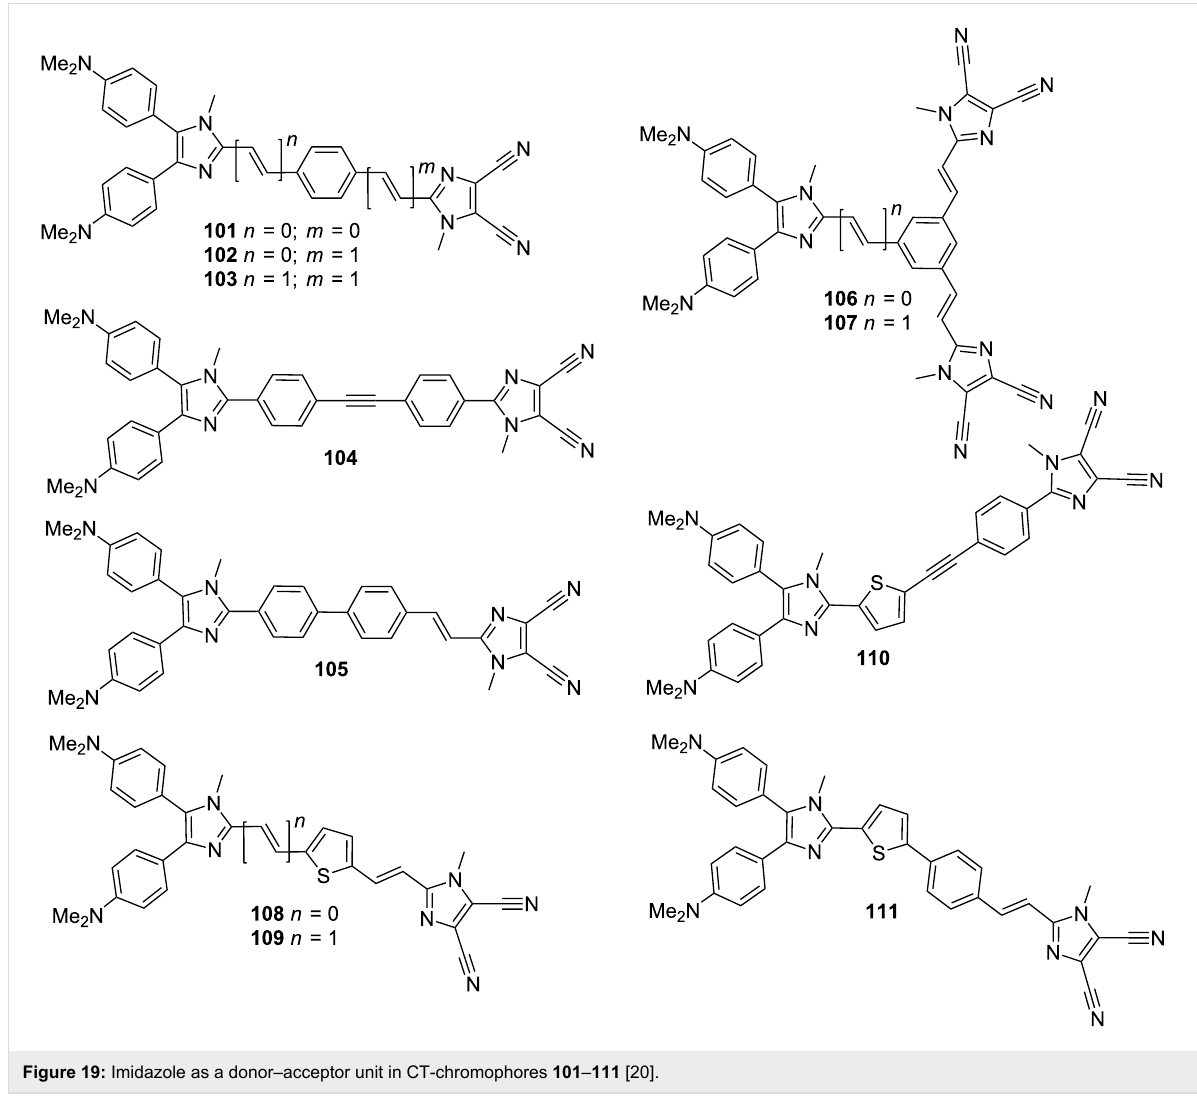
Figure 19: Imidazole as a donor–acceptor unit in CT-chromophores 101 – 111 [20].